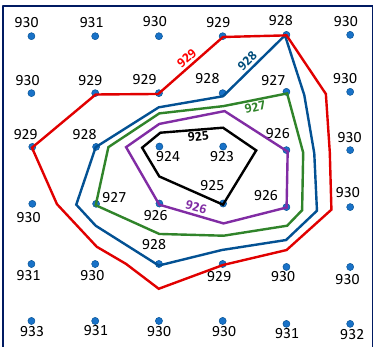
Figure 10. Illustration of elevation contour line construction for a sample elevation grid. The sample grid is a 6 × 6 grid with elevation at each grid point ranging from 923 m to 933 m above sea levels. In this example, contour lines for elevations 925 m, 926 m, 927 m, 928 m, and 929 m above sea level are